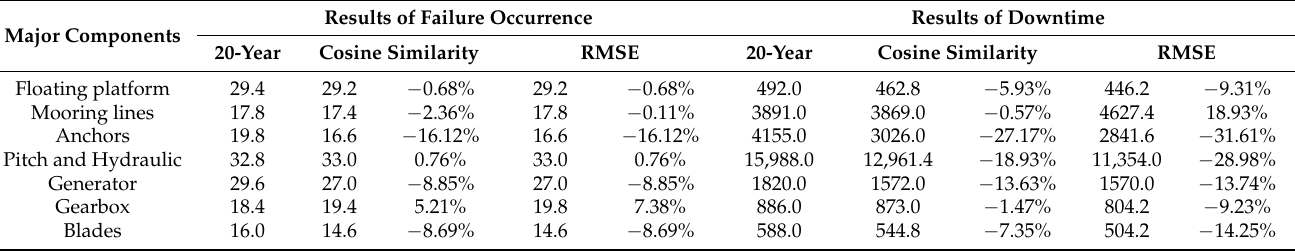
Table 7. The number of failure occurrences and the system downtime over the 20-year lifetime for the proposed model where cosine similarity is employed and for a test model where RMSE is considered in the refined